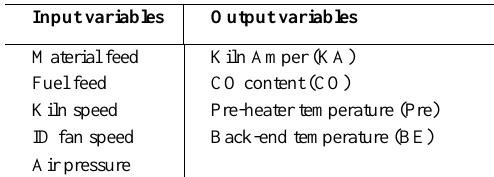
Table 1. The input and output variables of